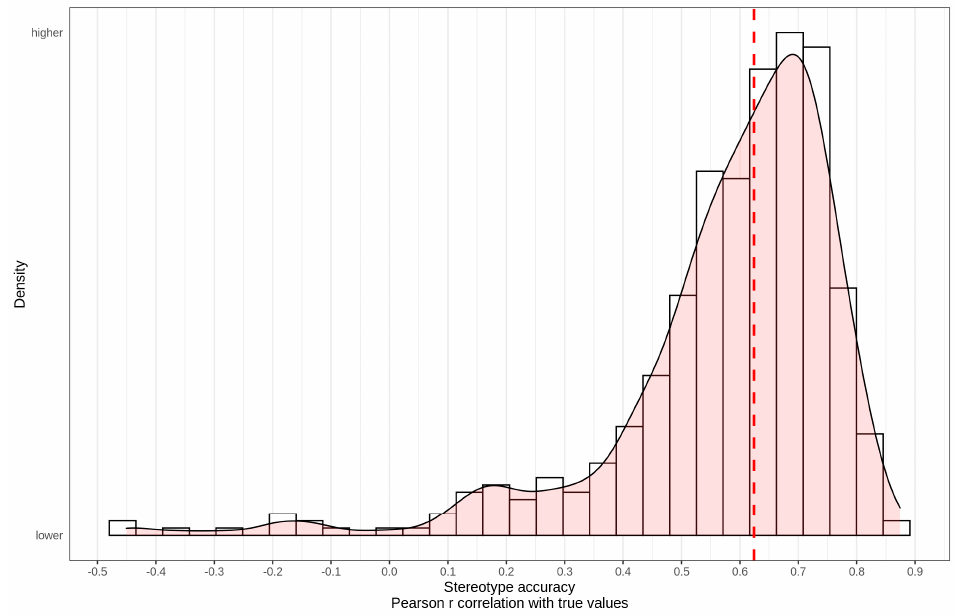
Figure 5. Distribution of individual stereotype accuracy (Pearson r). Vertical line = median.